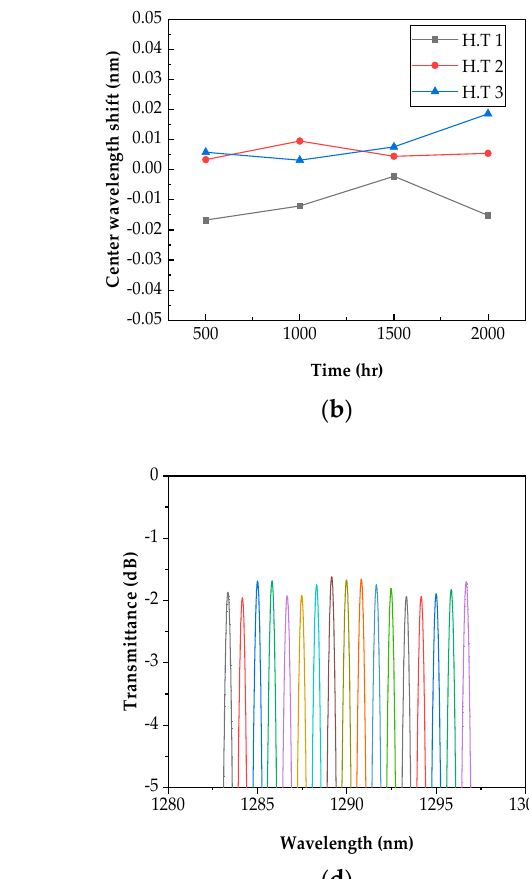
testing (H.T.): ( a ) IL deviation; ( b ) C.W. shift; ( c ) Spectrum (H. T. 1); ( d ) Zoom in spectrum around 0